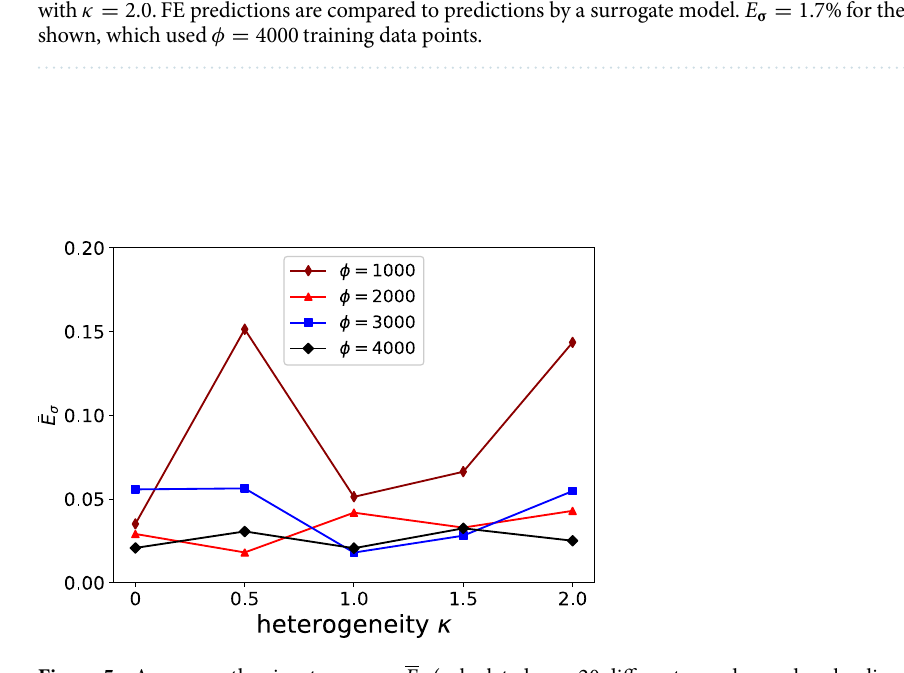
Figure 5. Average path-wise stress error E σ (calculated over 20 different pseudo-random loading paths) as a function of the heterogeneity κ and the number of training datapoints φ